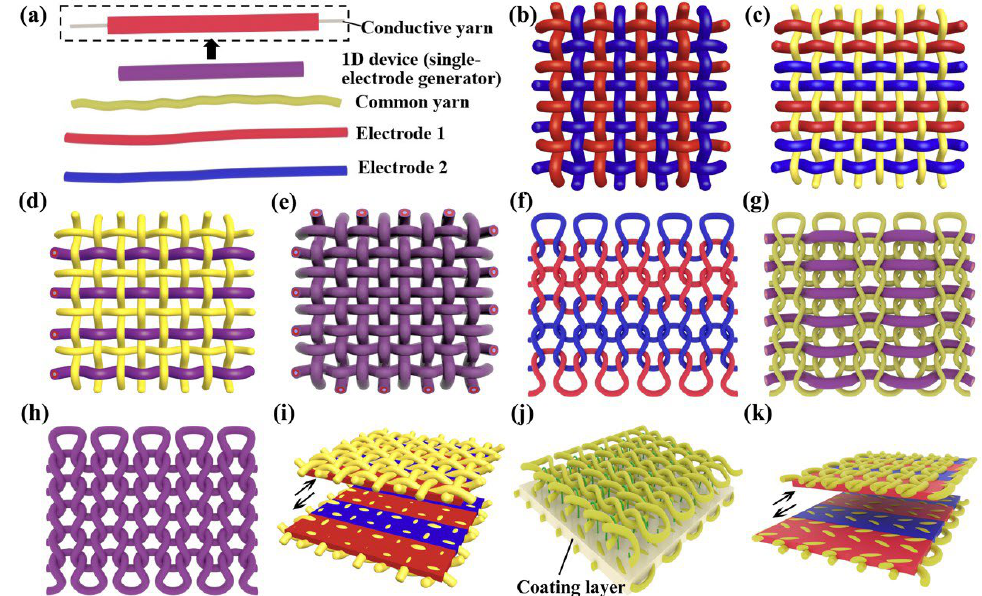
Figure 1. Schematic of the textile-based generators used in human clothing. ( a ) The basic elements of a textile-based generator. ( b ) Woven-structure generator based on two kinds of 1D electrodes. ( c ) Woven-structure generator based on two kinds of 1D electrodes and common yarns. ( d ) Woven- structure generator based on two kinds of 1D devices and common yarns. ( e ) Woven-structure generator based on 1D devices. ( f ) Knitted-structure generator based on two kinds of 1D electrodes. ( g ) 1D device sewn into common knitted fabric. ( h ) Knitted-structure generator based on 1D devices. ( i ) Woven-structure generator based on fabric coated with functional layers. ( j ) 3D spacer fabric- structure generator and ( k ) knitted-structure generator based on fabric coated with functional